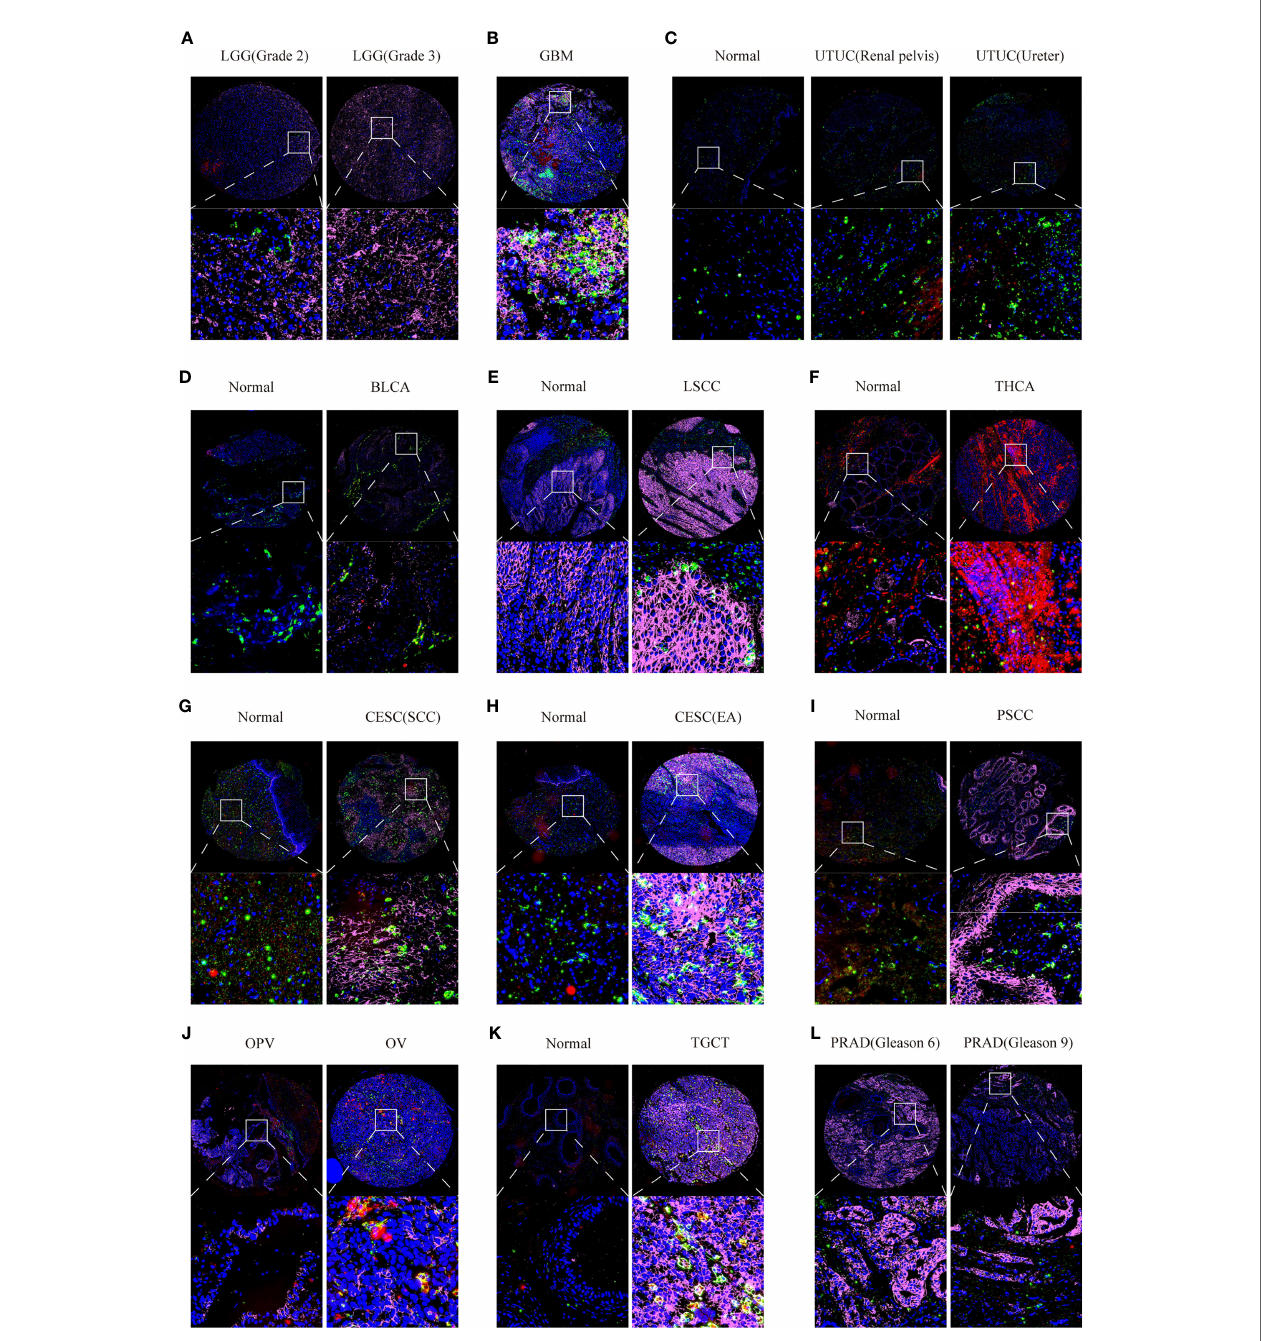
FIGURE 8 | Multiplex immuno fl uorescence staining analyzing CD147 co-expression on macrophage and M2 macrophage in pan-cancer. The expression levels of CD147 on macrophage and M2 macrophage in LGG (A) , GBM (B) , UTUC (C) , BLCA (D) , LSCC (E) , THCA (F) , CESC (G, H) , PSCC (I) , OV (J) , TGCT (K) , and PRAD (L)